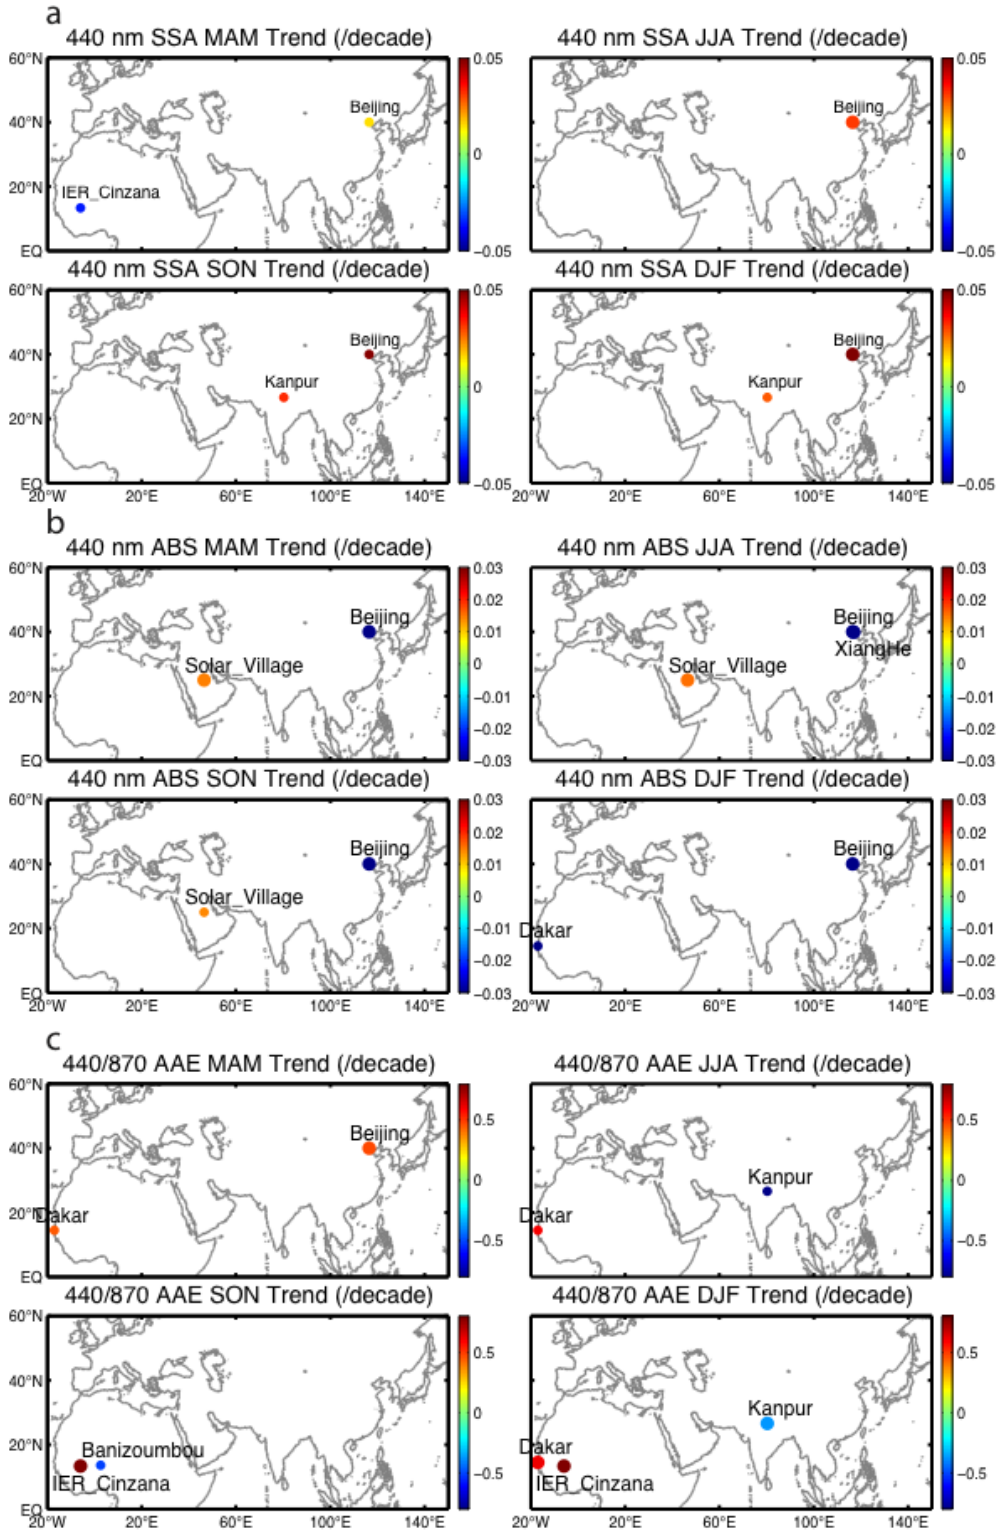
Figure 9. Seasonal trends for SSA (a) , ABS (b) and AAE (c) at the level 2.0 stations. Only statistically significant ( > 90%) trends are shown. The smaller dots indicate trends at 90% significance, while larger dots indicate trends at 95% significance. The magnitude of the trend (decade − 1 ) is indicated by the color of the dots, following the color scale on the right.